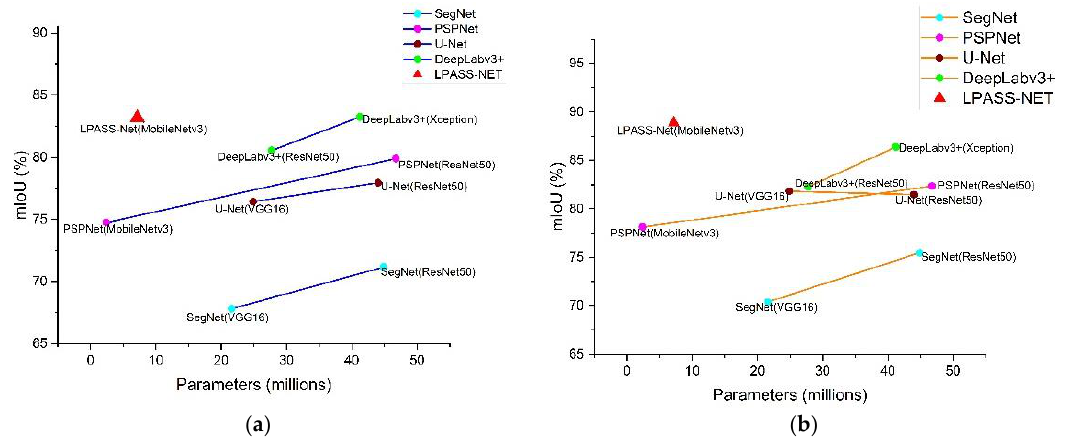
Figure 14. Model size vs. mIoU and mF1 in ( a ) the BDCI 2017 dataset and ( b ) the ISPRS Potsdam dataset. Details are in Table 5. Note that our approach obtains better results while having less model complexity.